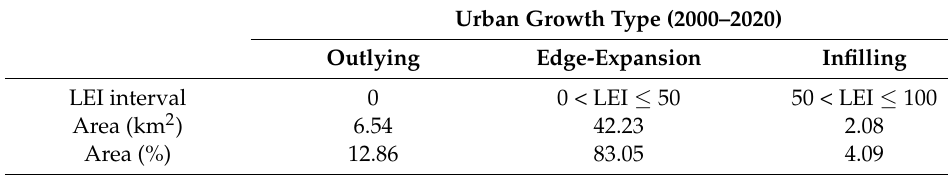
Figure 8. Urban growth pattern of Enshi City. Table 4. Results of urban growth types of Enshi City from 2000 to 2020.